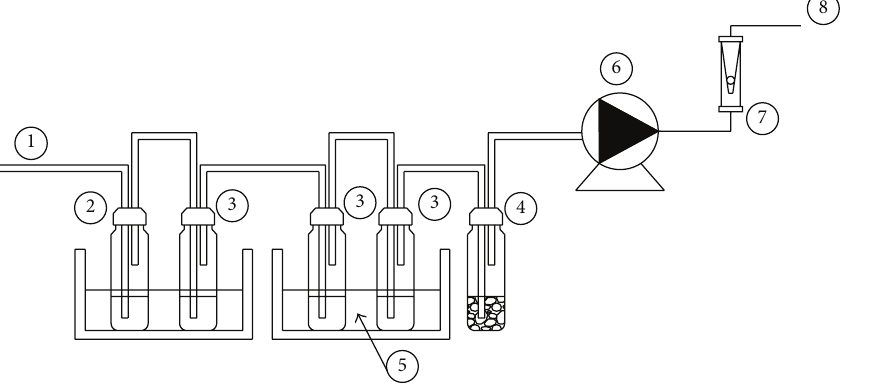
Figure 4: Schematics of gas sampling train: (1) gas from sampling line, (2) moisture collector, (3) series of impinge bottles, (4) backup VOC adsorber (5) ice bath at − 20 ∘ C, (6) suction pump, (7) rotameter for measuring sampled gas flow rate, (8) gas outlet.